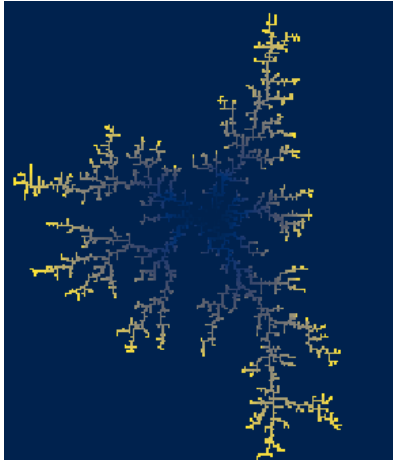
Figure 1. Fractal example using DLA.